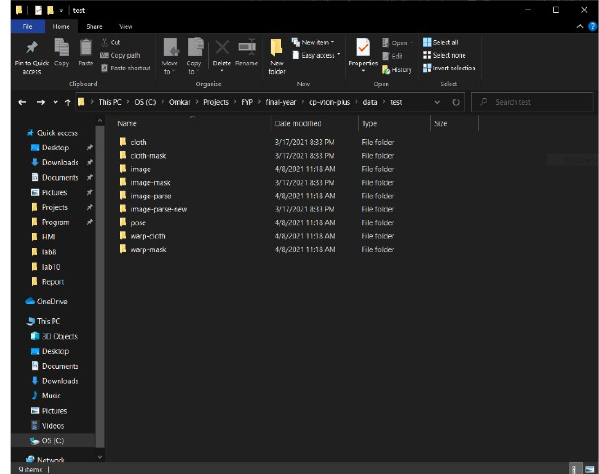
Fig. 2. Dataset by VITON